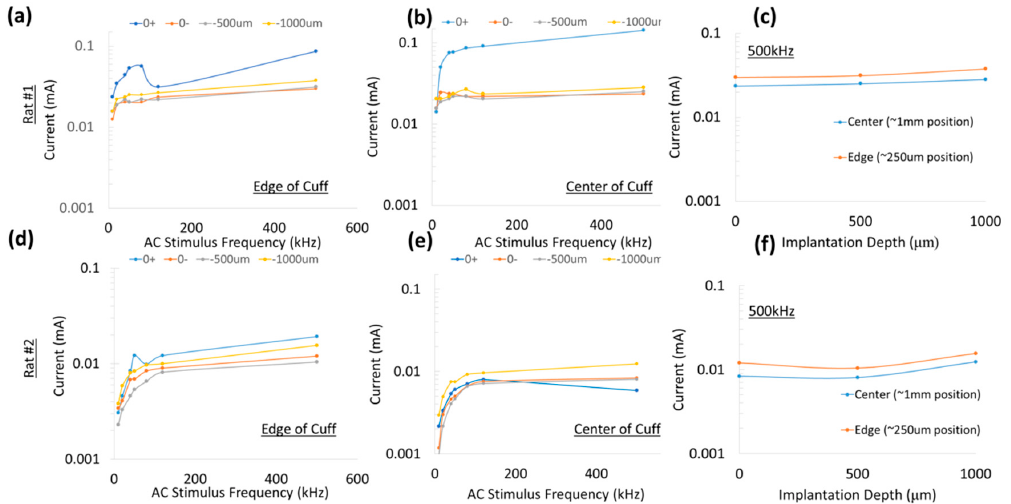
Figure 11. Characterization of current through a remote diode at 3 different implantation depths and 2 different lateral positions along the cuff. All currents were measured in response to a peak-to-peak excitation voltage of 1 V applied across rings ‘1’ and ‘9’ of the cuff electrode. ( a , d ) Current through diodes placed at the ‘edge’ of the cuff in 2 different animals and ( b , e ) ‘center’ of the cuff for 3 different depths—above the epineurium (0+), just below the epineurium (0 − ), at 500 µm and 1 mm implantation depths. ( c , f ) Representative currents through the diodes at 500 kHz are shown for different implantation depths and position. The highest currents were attained closer to the epineurium (0 or 1 mm depth) of the nerve and closest to the stimulating electrodes.